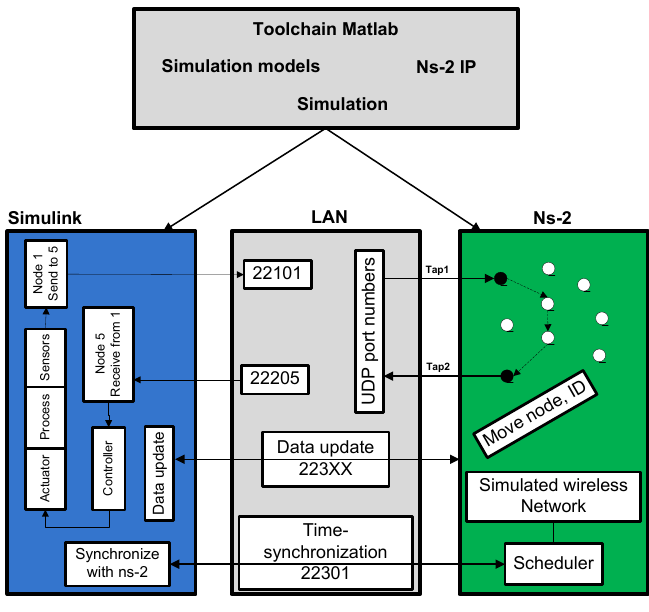
Figure 3. PiccSIM tool chain [32].